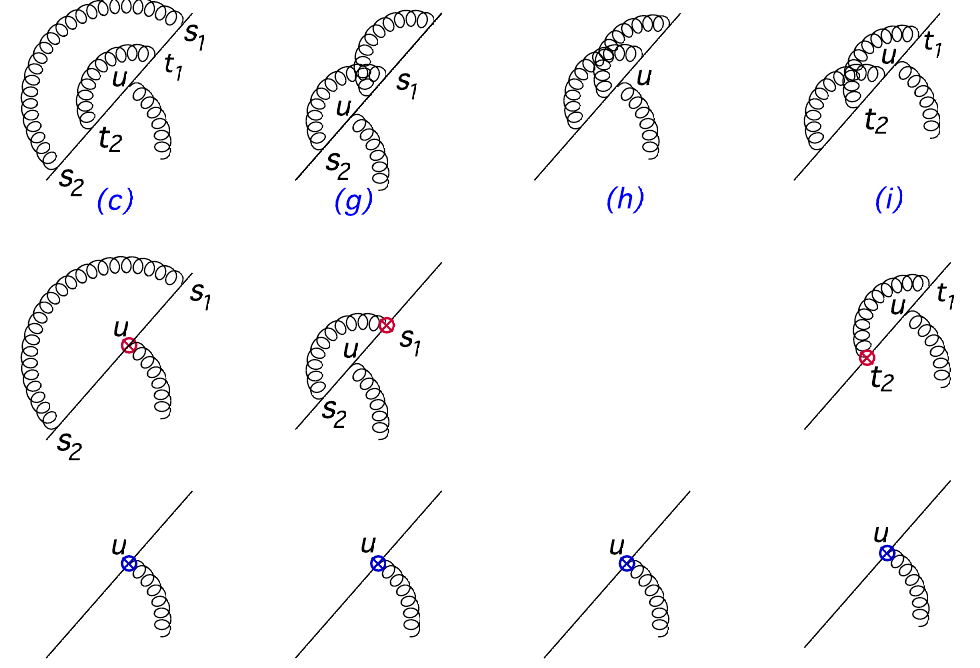
Figure 11 . Renormalization of the (5,1) web. Upper row: the boomerang gluon subdiagram in diagrams ( c ) , ( g ) , ( h ) and ( i ) ; Second row: one-loop counterterm contributions to the above diagrams associated with shrinking the innermost boomerang gluon to a point; Third row: two- loop counterterm contributions to the above diagrams associated with simultaneously shrinking both boomerang gluons to a